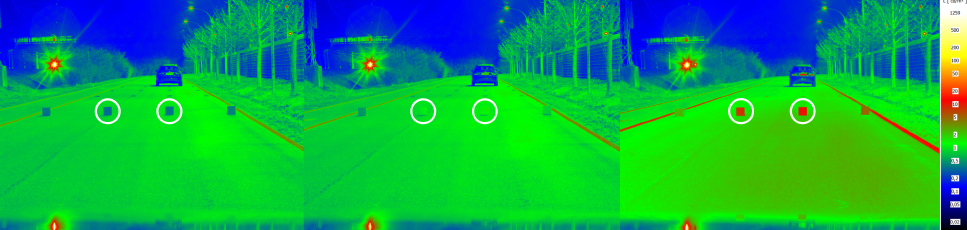
Figure 9. Illustration of the transition from negative contrast to positive contrast; the two objects in the middle are clearly visible with the negative contrast ( left ), while an increase in the low beam intensity leads to a neutralization of the contrast and makes the objects disappear ( center ) and a further increase in the low beam intensity makes the objects visible again ( right